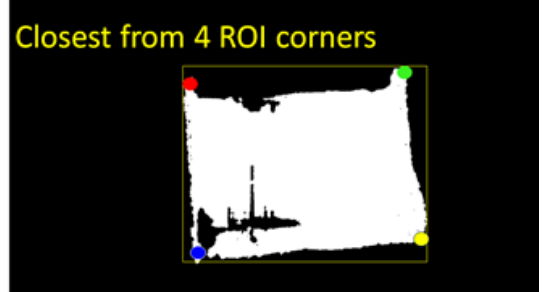
Figure 11. Three-dimensional model of the cargo area.